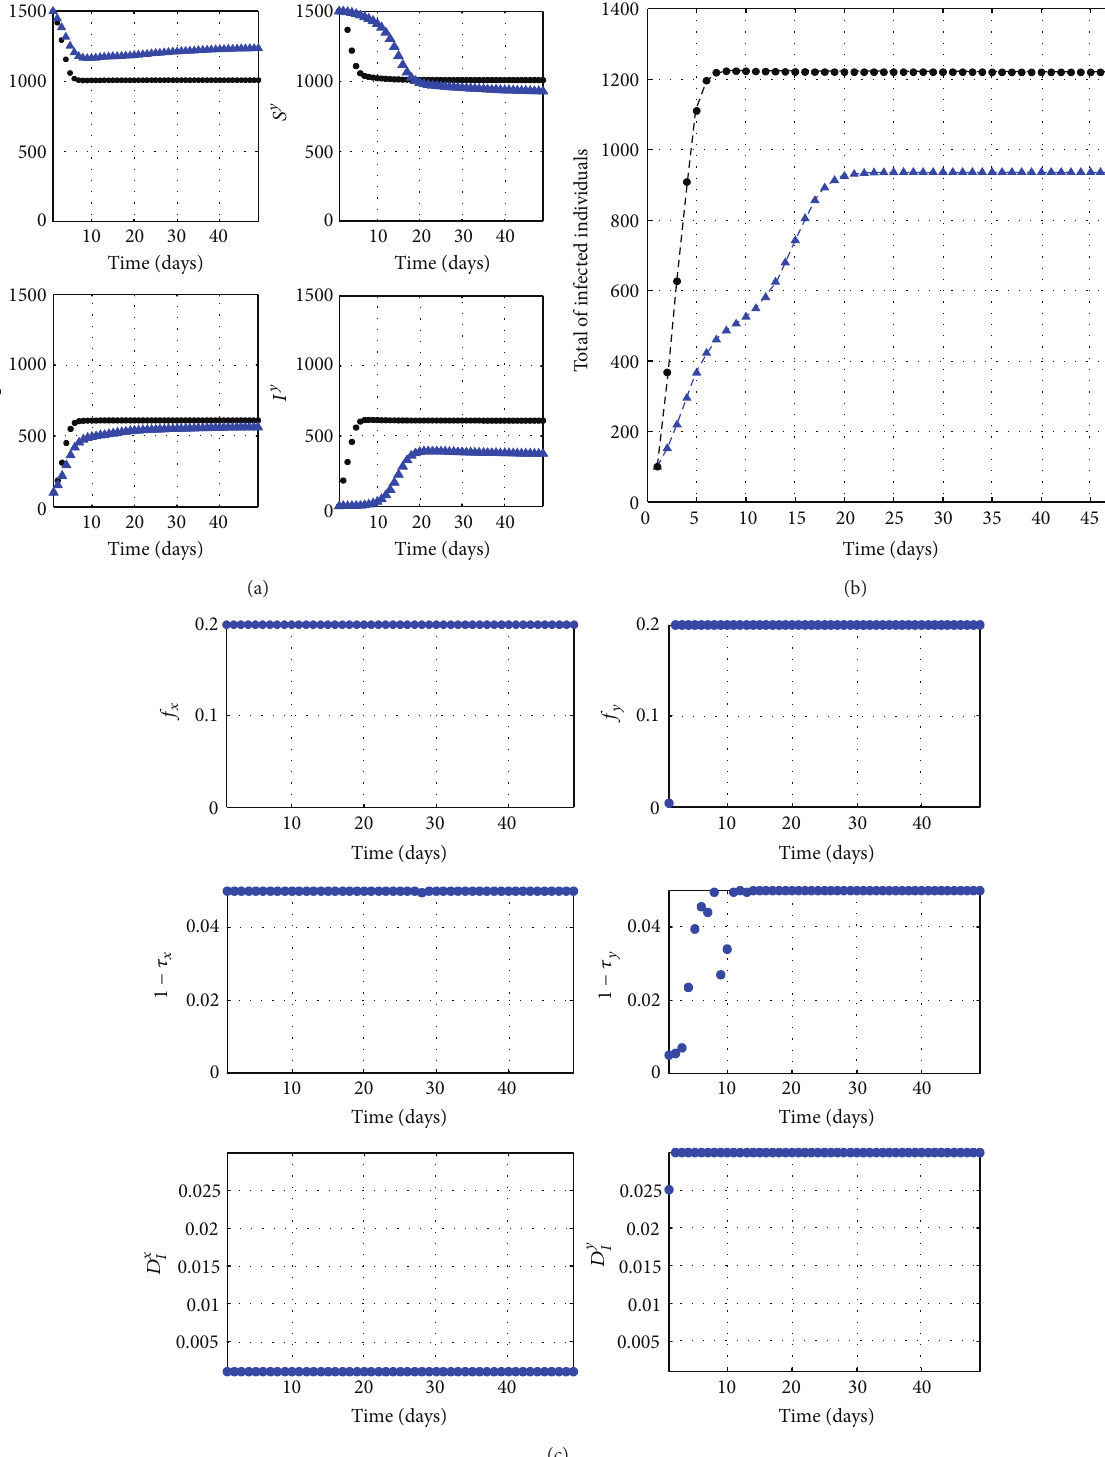
Figure 3: (a) The population of susceptible and infected individuals for the worst case ( ∙ ) and the results of applying the minimizing algorithm ( 󳵳 ). (b) Total of infected individuals in both populations presents the worst case ( ∙ ) and the minimized results ( 󳵳 ). The delay in the introduction of infective individuals produces an apparent reemergence. (c) Strategy that minimizes the combined costs of the disease impact and the control of the disease